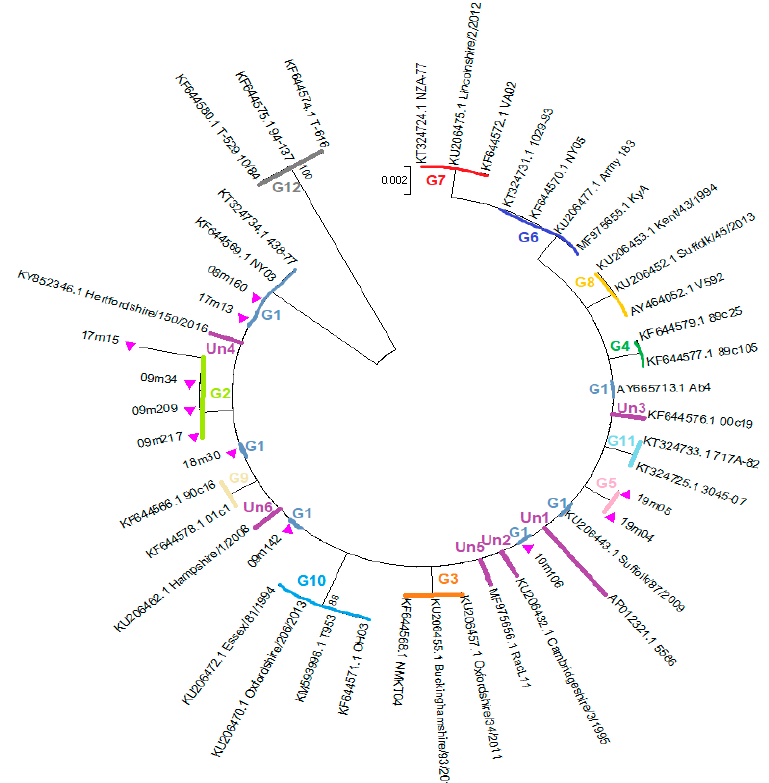
Figure 2. The evolutionary history of the ORF34 sequences was obtained by Neighbor-Joining method with bootstrap test with 1000 replicates. The evolutionary distances were computed using the Tamura 3-parameter method and are in the units of the number of base substitutions per site. Sequences obtained in this study are marked with a triangle ▲ . The letter “G” followed by a number indicates the number of the group where the sequences are located. The letters “Un” followed by a number indicates the sequences not located in any Group.